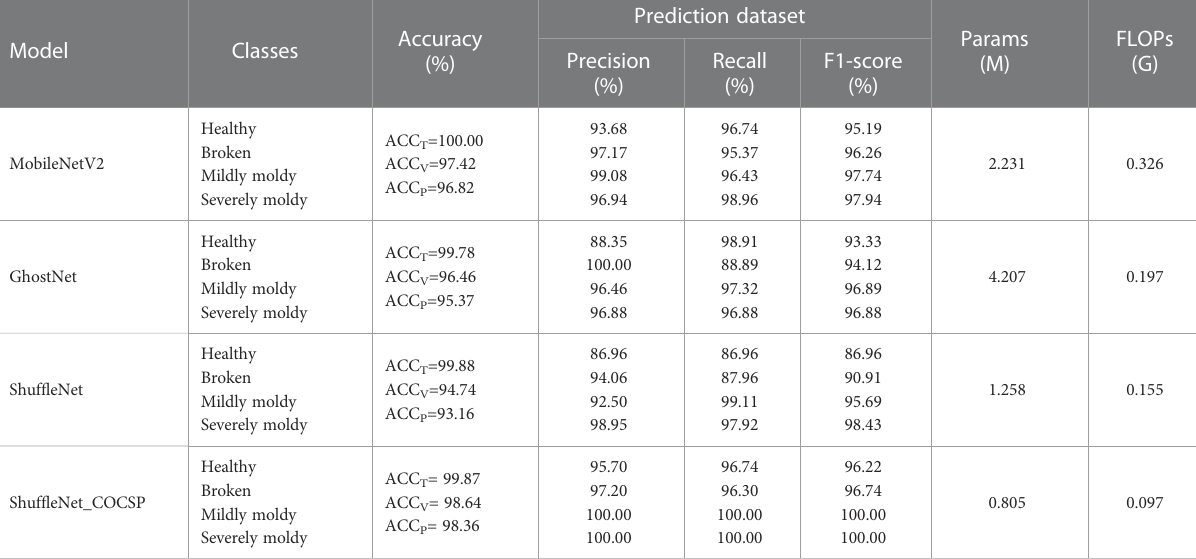
TABLE 3 Classi fi cation results of soybean kernels using MobileNetV2, GhostNet, Shuf fl eNet and Shuf fl eNet_COCSP.